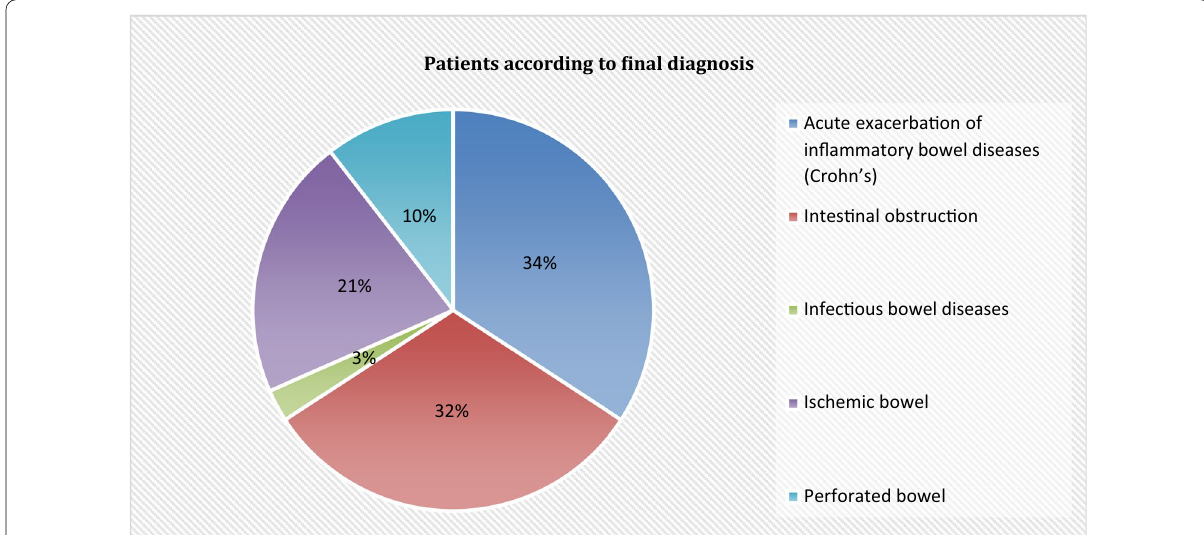
Fig. 1 Distribution of studies cases according to final